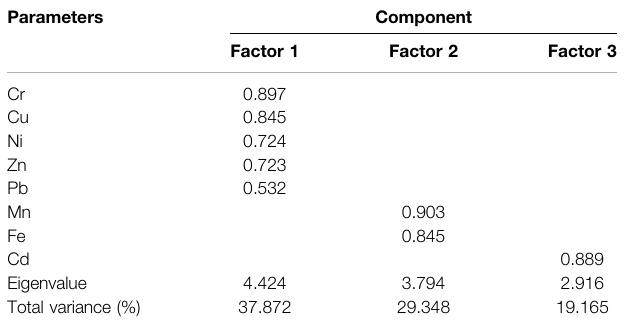
TABLE 4 | Loading corresponding to three factors for surface sediments of the Jian and Moyang